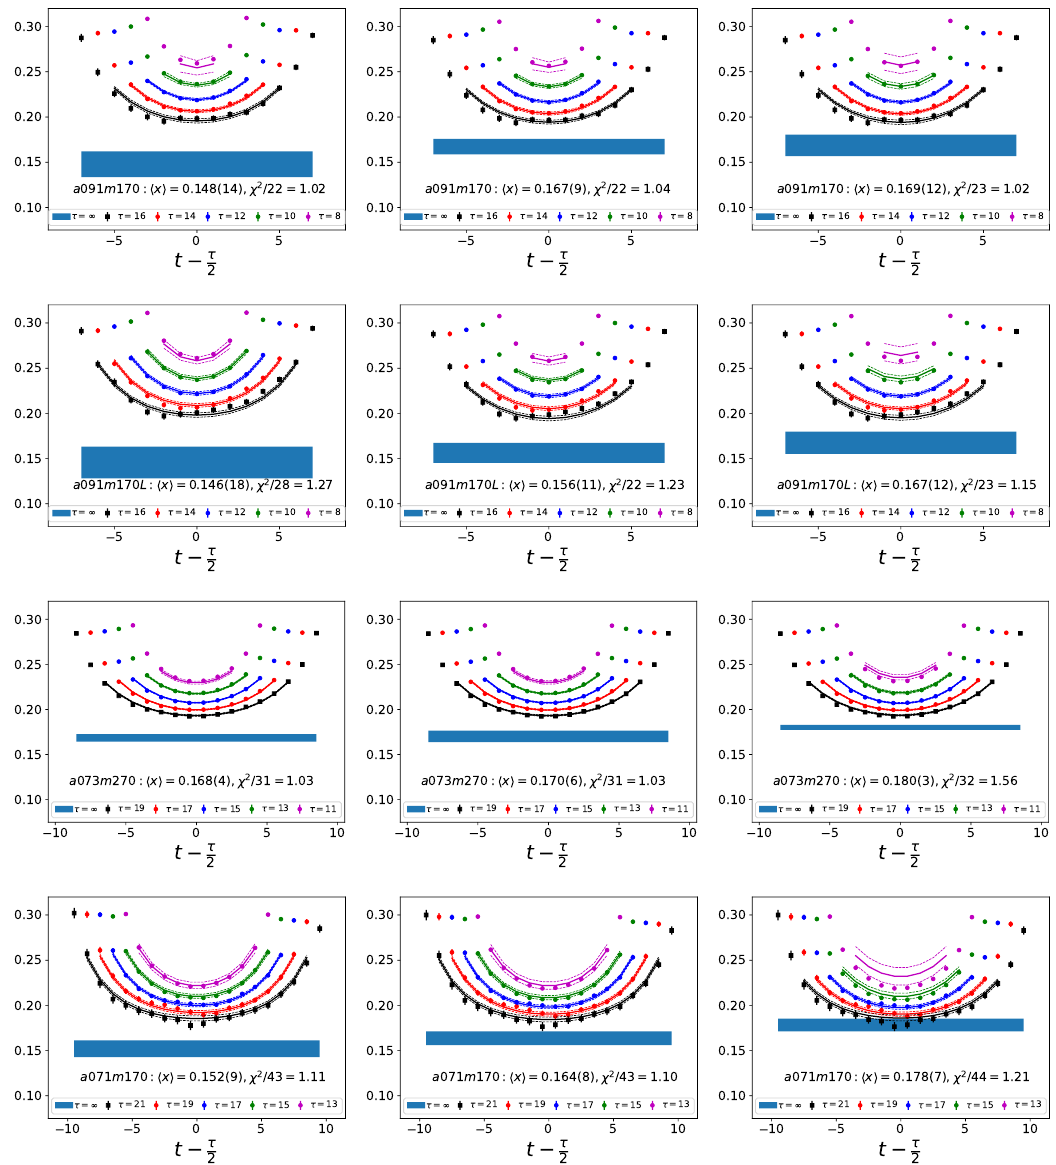
Figure 6 . Continuation of the data and fits to remove excited-state contamination in the extraction of the momentum fraction h x i for a 091 m 170 (top row), a 091 m 170 L (second row), a 073 m 270 u − d (third row), and a 071 m 170 (bottom row). The data for the ratio C 3 pt ( τ ; t ) /C 2 pt ( τ ) is scaled using O eq. (3.8) to give h x i , and the fit parameters are listed in table 7. The rest is the same as in u − d figure